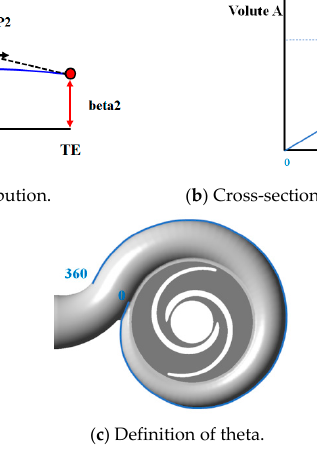
Figure 7. Definition of the design variables.